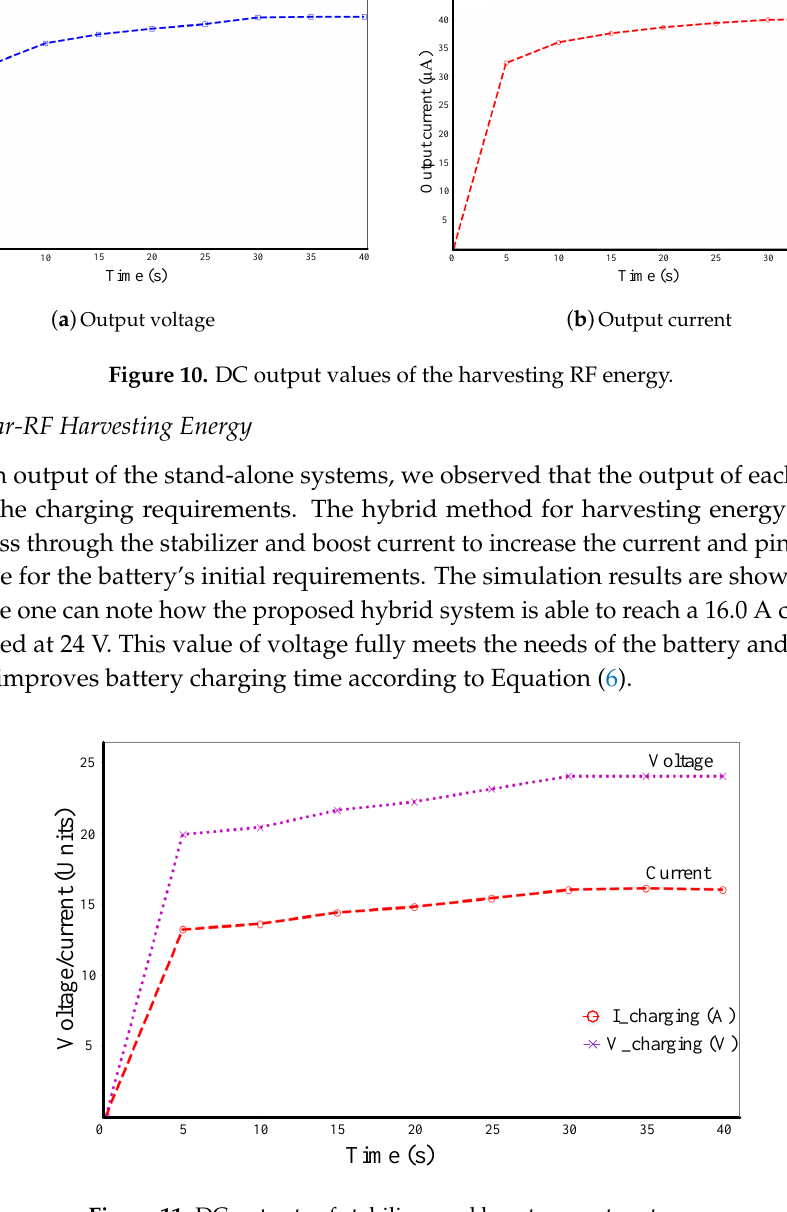
Figure 11. DC outputs of stabilizer and boost current